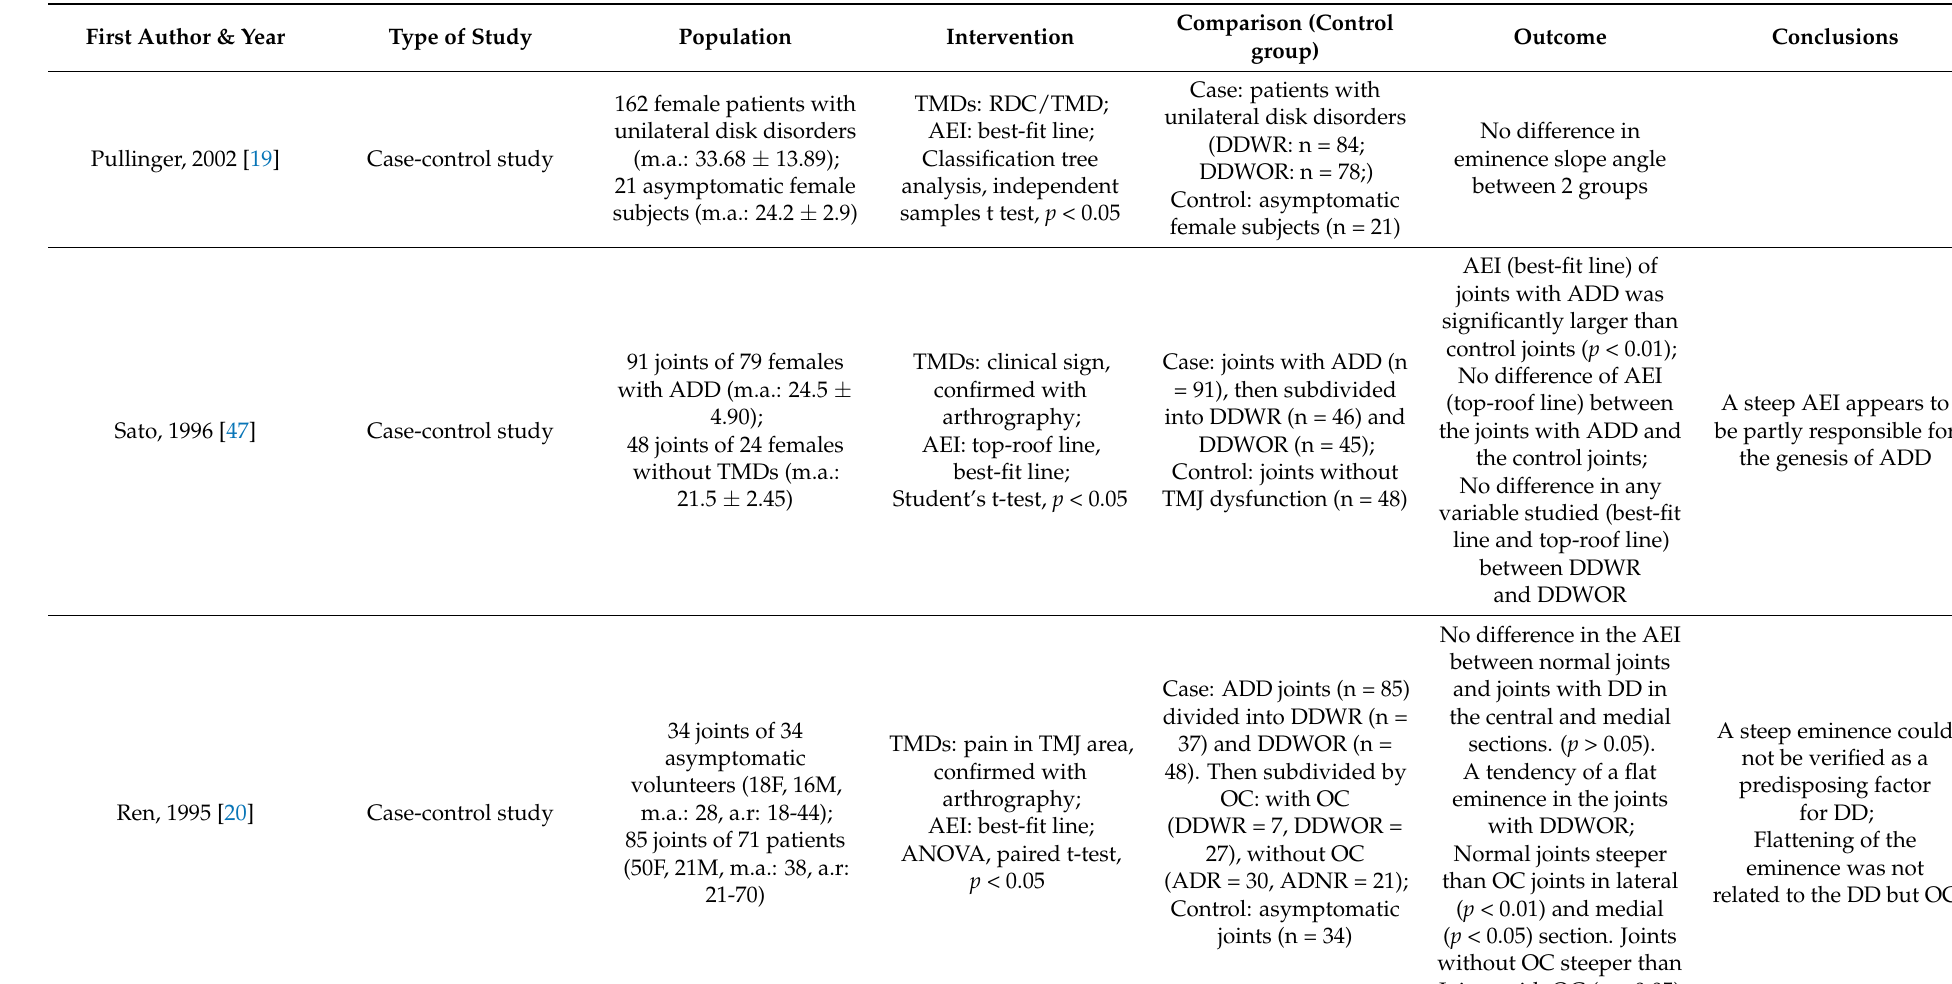
Table 5. Summary of findings from studies of TMDs and AEI with two-dimensional